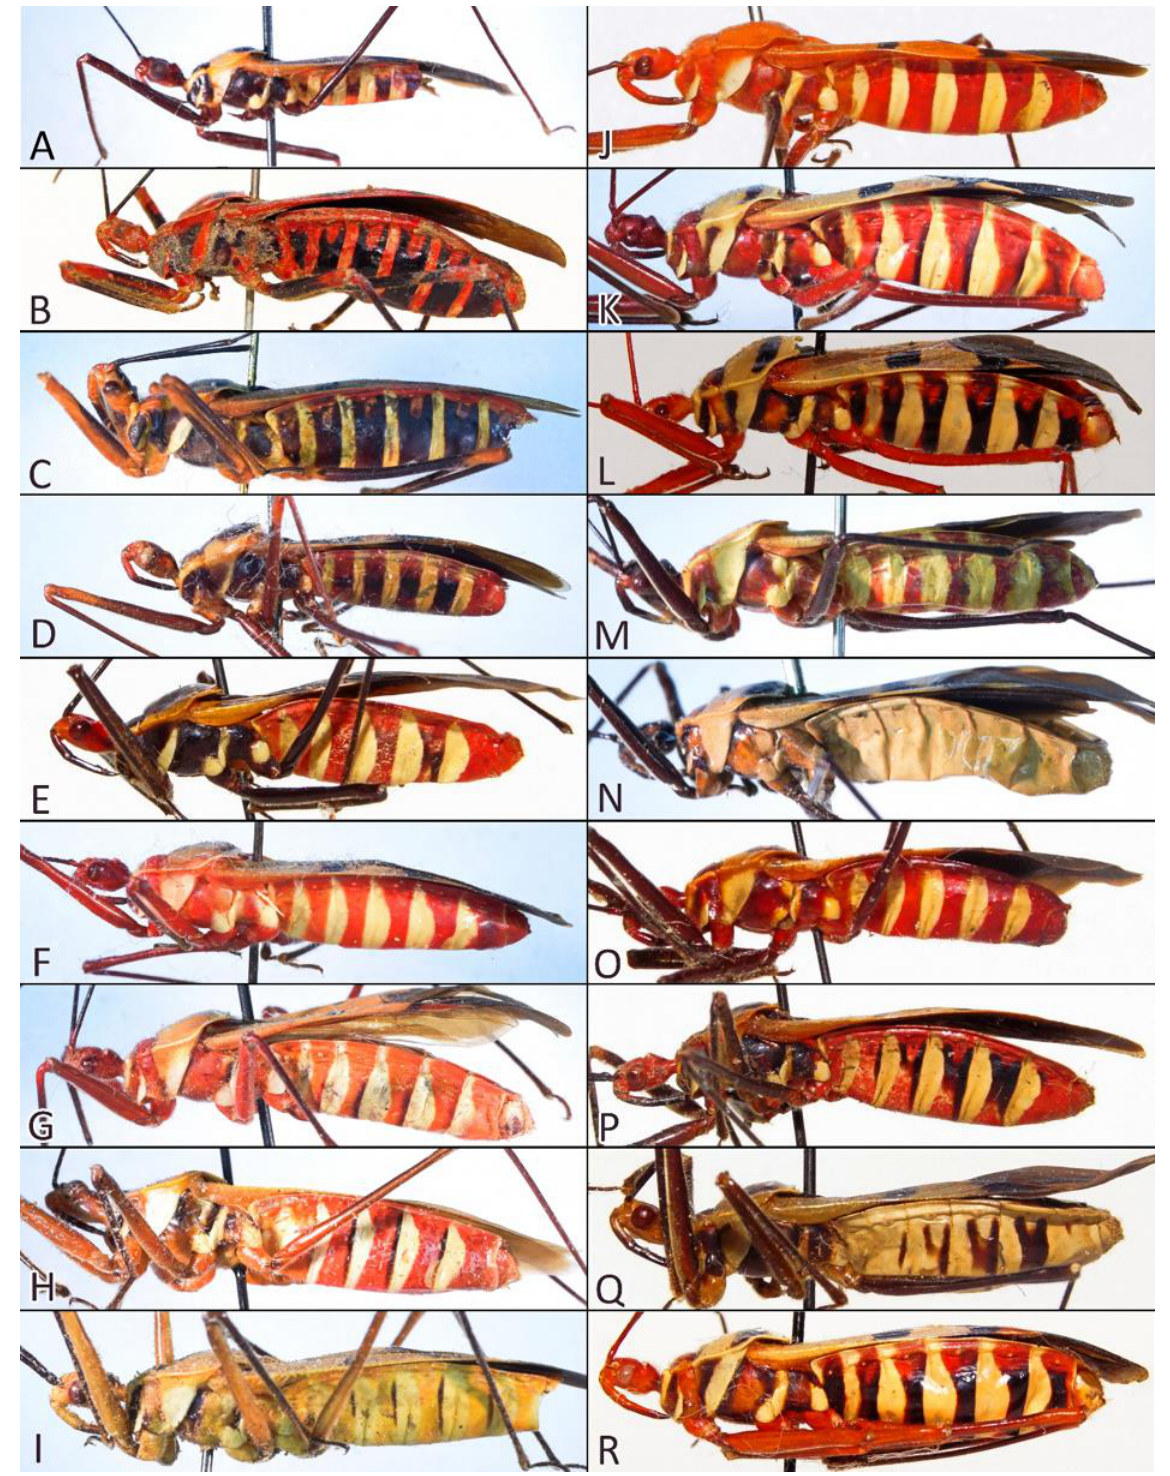
Figure 26. Lateral view of individuals representing species of the genus Phonoctonus Stål, 1853: ( A ) Phonoctonus bifasciatus Villiers, 1948; ( B , C ) P. caesar Haglund, 1895; ( D ) P. elegans Varela, 1904; ( E ) P. fairmairei Villiers, 1948; ( F ) P. fasciatus (Beauvois, 1805); ( G ) P. grandis Signoret, 1860; ( H , I ) P. immitis Stål, 1865; ( J ) P. luridus Miller, 1950; ( K , L ) P. lutescens (Guérin-Méneville & Percheron, 1834); ( M , N ) P. nigrofasciatus Stål, 1855; ( O ) P. picta Schouteden, 1932; ( P , Q ) P. picturatus Fairmaire, 1858; and ( R ) P. principalis Gerstaecker, 1892.